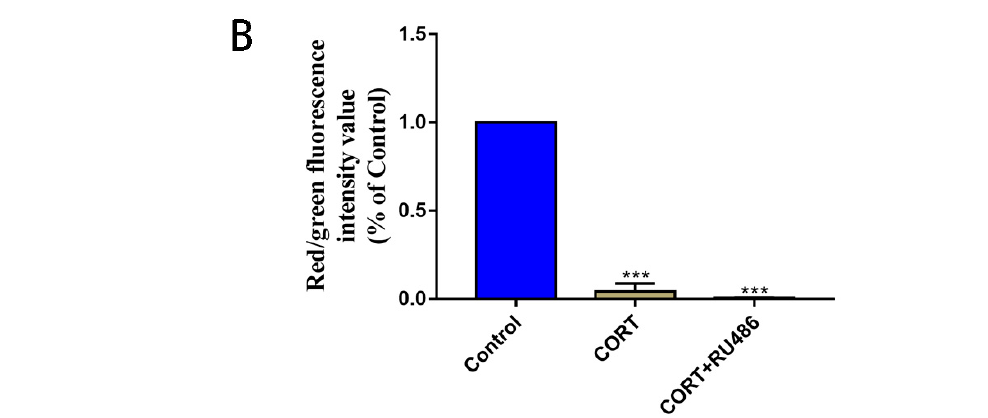
Figure 7. ∆Ψ m of HT22 cells was measured by JC-1 staining with 400 µ M cortisol treatment for 3 h with or without RU486. The red color denotes JC-1 aggregates, and the green color denotes monomers ( A ). The bar graph shows the ratio of red to green fluorescence at every time point ( B ). Data were compared with control and analyzed by one-way analysis of variance. The results are expressed as the mean ± SD ( n = 3) in each independent experiment; *** p < 0.001.